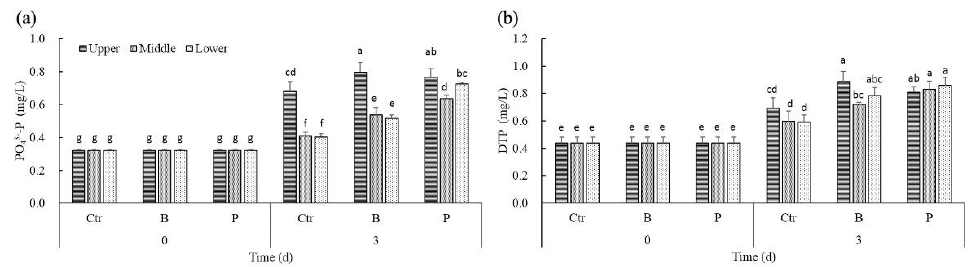
Figure 4. The effect of algicidal and denitrifying bacteria on PO 43 − -P ( a ) and DTP ( b ) concentrations in the different layers of water.